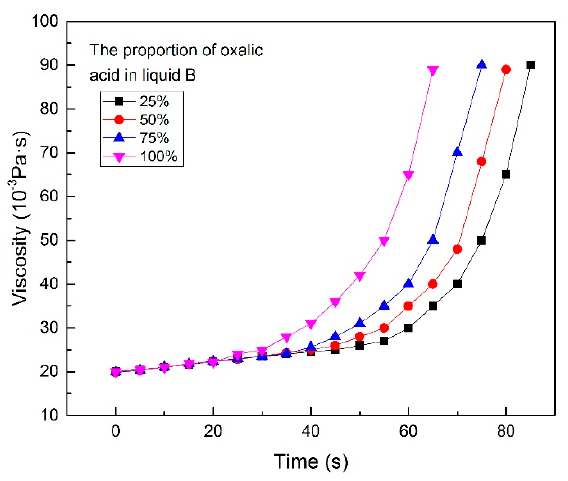
Figure 2. Curve of viscosity versus time under different proportions of oxalic acid in liquid B.